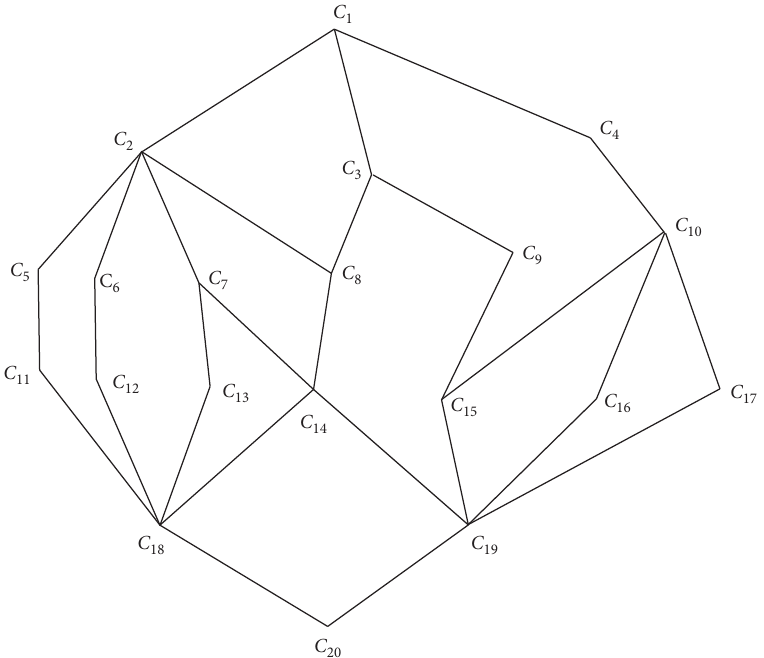
Figure 3: LTV-CL L ( K